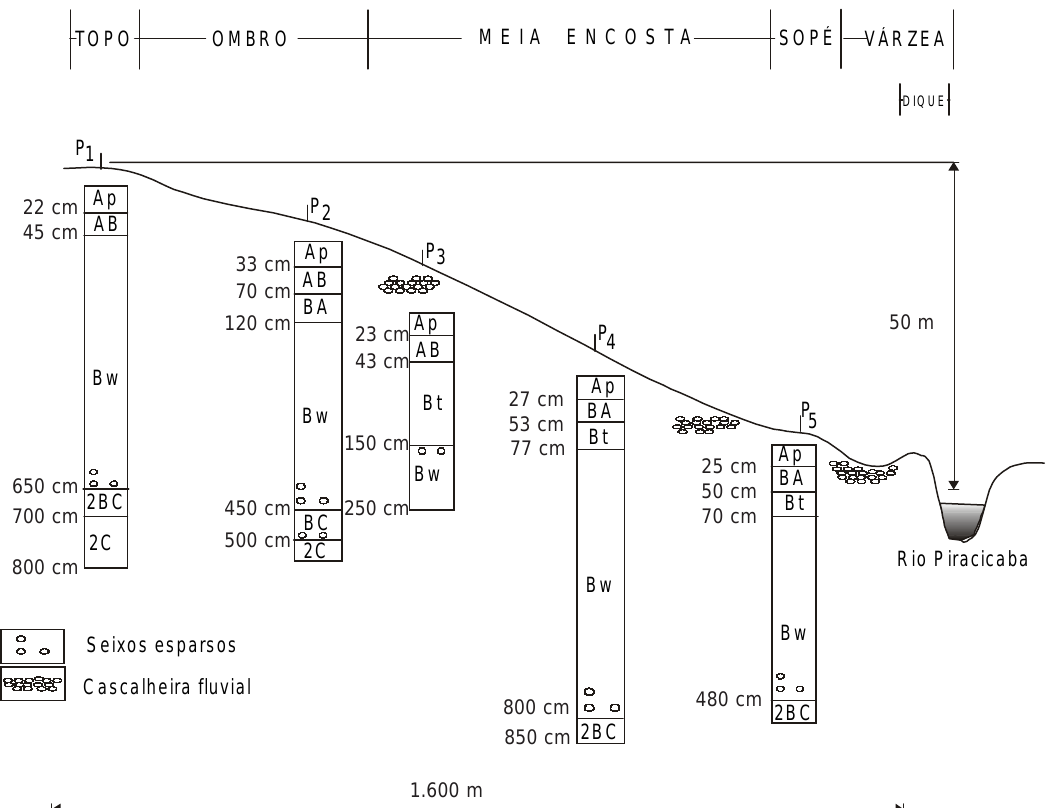
Figura 3. Representação esquemática da seqüência de solos estudada. P1: Latossolo Vermelho-Escuro álico textura muito argilosa; P2: Latossolo Vermelho-Escuro álico textura argilosa; P3: Podzólico Vermelho-Amarelo Latossólico álico textura média; P4 e P5: Podzólico Vermelho-Escuro Latossólico álico textura